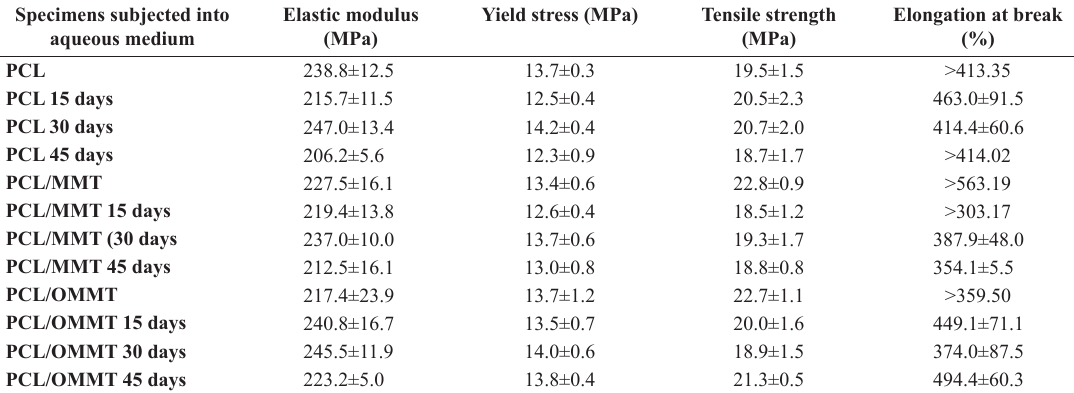
Table 1: Mechanical properties of PCL and PCL/MMT and PCL/OMMT compounds subjected into aqueous medium at 40 o C Specimens subjected into Elastic modulus Yield stress (MPa) Tensile strength aqueous medium (MPa) (MPa)